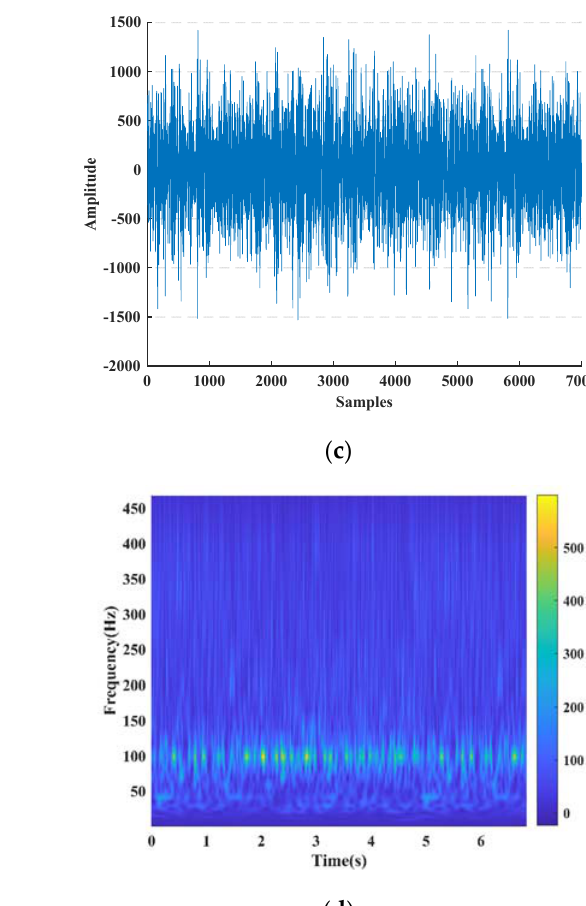
Figure 6. Recognition accuracy rates for different training percents . Microseismic events and noise can be classified by the WSD-SVM algorithm effec- tively, as shown in Figure 6. As the following ten experiments illustrate, the recognition accuracy rates increased as the training percent became larger, reaching 99.6% in five ex- periments.